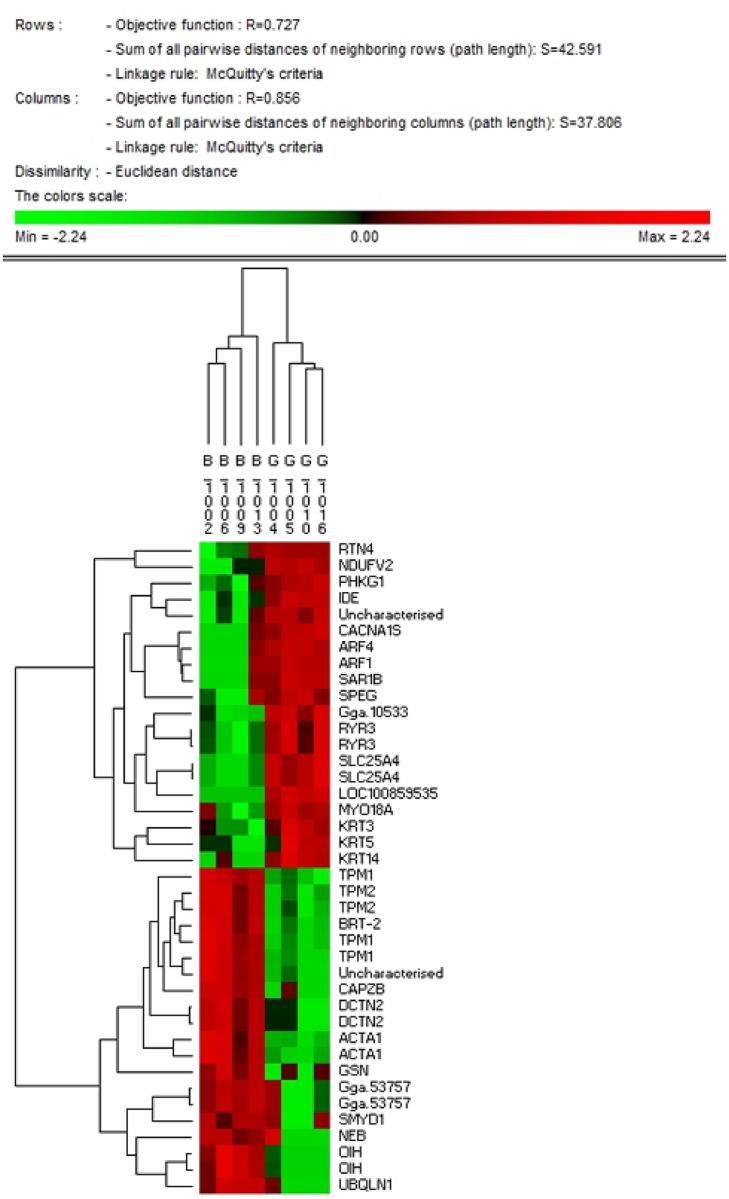
A hierarchically clustered heat map of the 40 most differentially expressed proteins as identified by PIF.Each cell contains the normalized expression of the protein at the individual bird level. Red denotes high expression, green denotes low expression. All 8 birds discriminate into their correct treatment group of origin (HFE or LFE) and relatedness within a group is also apparent. Proteins are clustered by patterns of co-expression across the 8 birds. Strong co-expression is observed for functionally related proteins e.g. ARF1 with ARF4 and KRT3 with KRT5 and KRT14 and the muscle structural proteins, namely TPM1, TPM2 and CAPZB. Different fragment of the same protein are highly co-expressed. Note: ‘B’ are birds with a low FE phenotype whereas ‘G’ are birds with a high FE phenotype. Abbreviations: (RTN4), reticulon 4; (NDUFV2), NADH dehydrogenase (ubiquinone) Fe-S protein 7; (PHKG1), phosphorylase kinase gamma 1; (IDE), insulin degrading enzyme; (CACNA15), calcium channel voltage dependent 1 L type, alpha 15; (ARF), ADP ribosylation factor 4 and 1; (SAR1B), SAR1-ADP ribosylation factor, (SPEG), striated muscle preferentially expressed protein; (Gga), golgi associated gamma adaptin; (RYR3) ryanodine receptor 3; (SLC26A4), adenine nucleotide translocase 1; (MYO18A), myosin 18A; (KRT), keratin; (TPM), tropomyosin; (BAT2), large proline rich protein; (CAPZB), F-actin capping protein subunit beta; (DCTN2), dynactin 2; (ACTA1), alpha actin 1; (GSN), gelsolin; (SMYD1), myosin interacting protein; (NEB), lambda protein phosphatase; (OIH) ovoinhibitor; (UBQLN), ubituilin family proteins